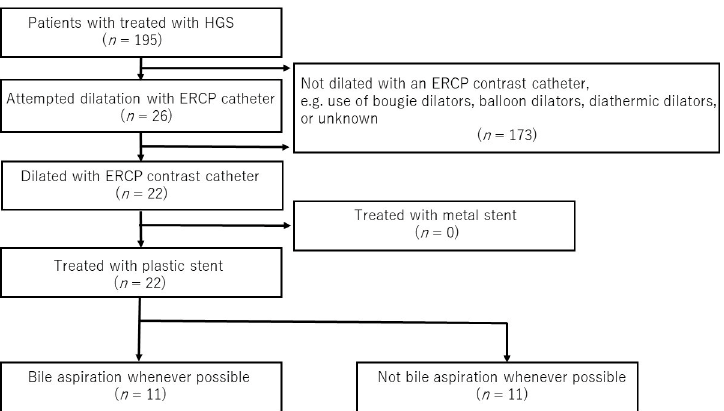
Figure 1. Flowchart of the study design. Abbreviations: ERCP, endoscopic retrograde cholangiopan- creatography; HGS, hepaticogastrostomy.